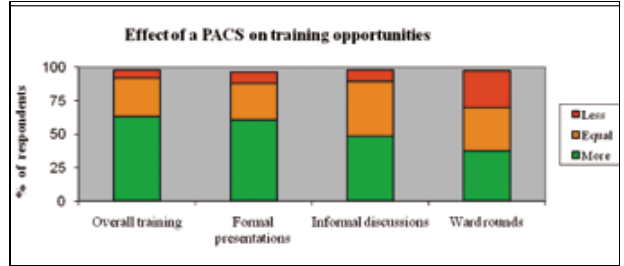
Fig. 6. The effects of a PACS on various training opportunities as perceived